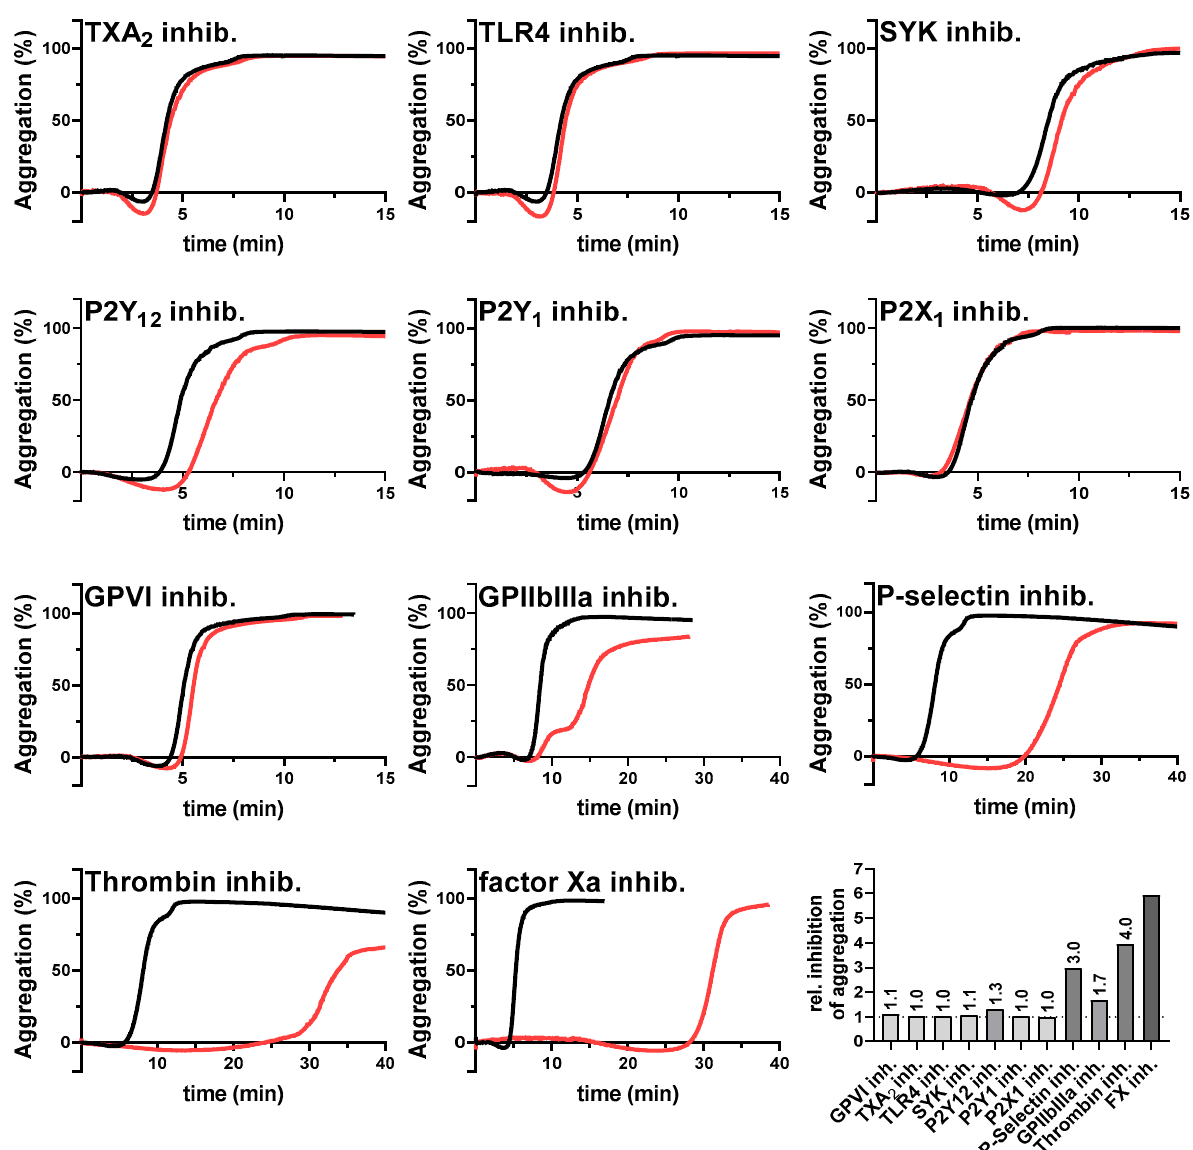
Figure 2. Inhibition of AsPC-1 cell-mediated platelet aggregation. Representative aggregation curves of platelets activated with 1×10 4 AsPC-1 cells/mL (black curves), or platelets preincubated with inhibitors for TXA2 receptor, TLR4, SYK tyrosine kinase, purinergic receptors P2Y 12 , P2Y 1 , P2X 1 , GPVI, GPIIbIIIa, P-selectin, thrombin, or factor Xa, respectively (red curves) ( n = 5). Effects of the different inhibitors on platelet aggregation are shown as ratio of time to half-maximal aggregation of treated versus untreated platelets.